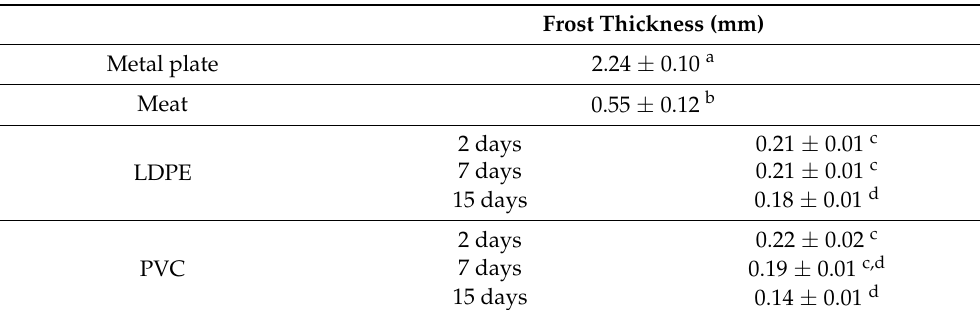
Table 2. Thickness of frost on the surface of the metal plate, unpacked meat, and packaged meat with respect to storage time.